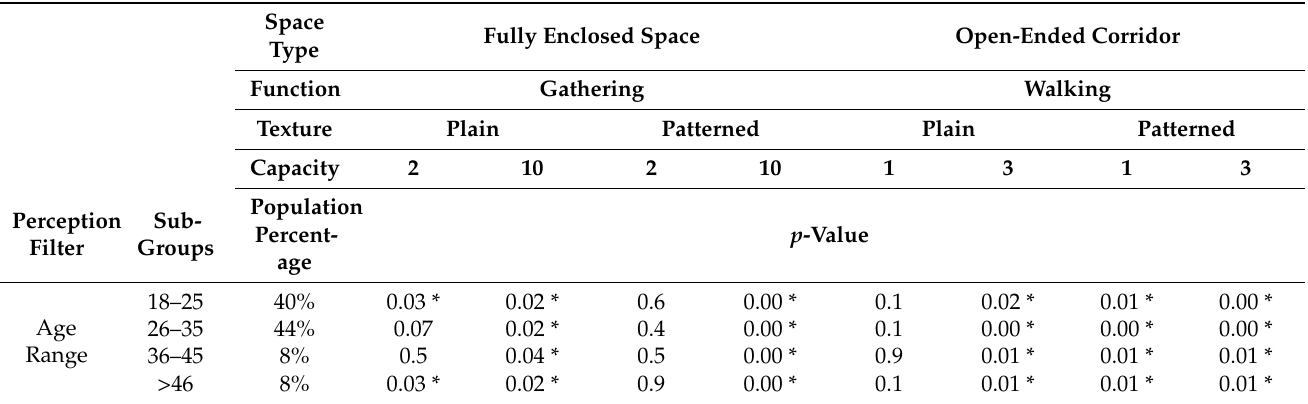
Table 2. Age range perception filter and comparisons of space size variations between IVRIE and DT